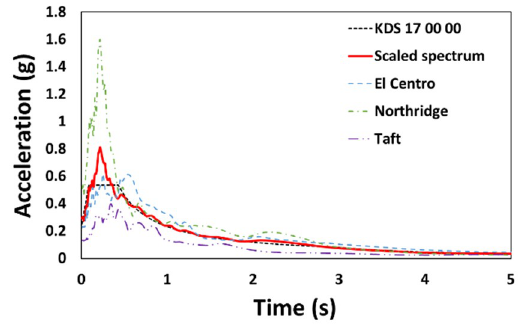
Figure 5. Scaled response spectrum.